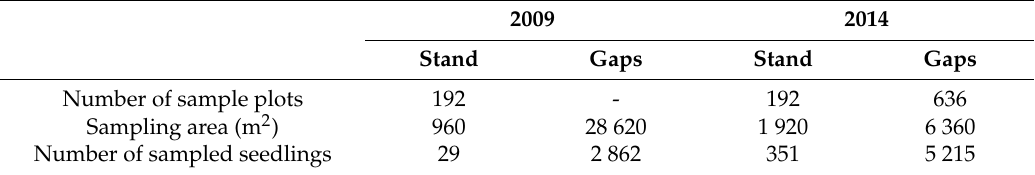
Stand Stand Gaps Number of sample